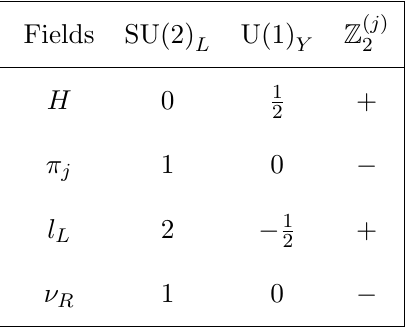
Table 1 . Particle content of the toy